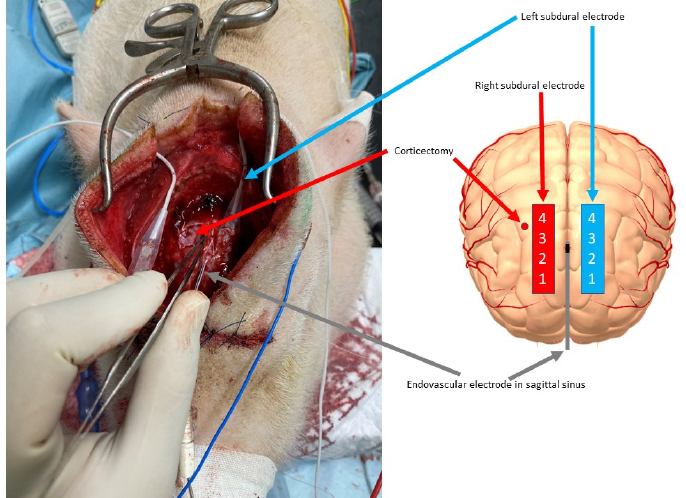
Figure 3. Corticectomy for placement of the epileptogenic focus and positioning of the subdural and endovascular electrodes. On the right frontal area, corticectomy for the epileptogenic focus was performed, 5 mm lateral to the epileptogenic focus and between contacts 3 and 4 of the right subdural electrode (red arrow). The left subdural electrode (sky blue arrow) and endovascular electrode (gray arrow) were already placed ( left ). The location of each electrode and the artificially created epileptogenic area are shown schematically ( right